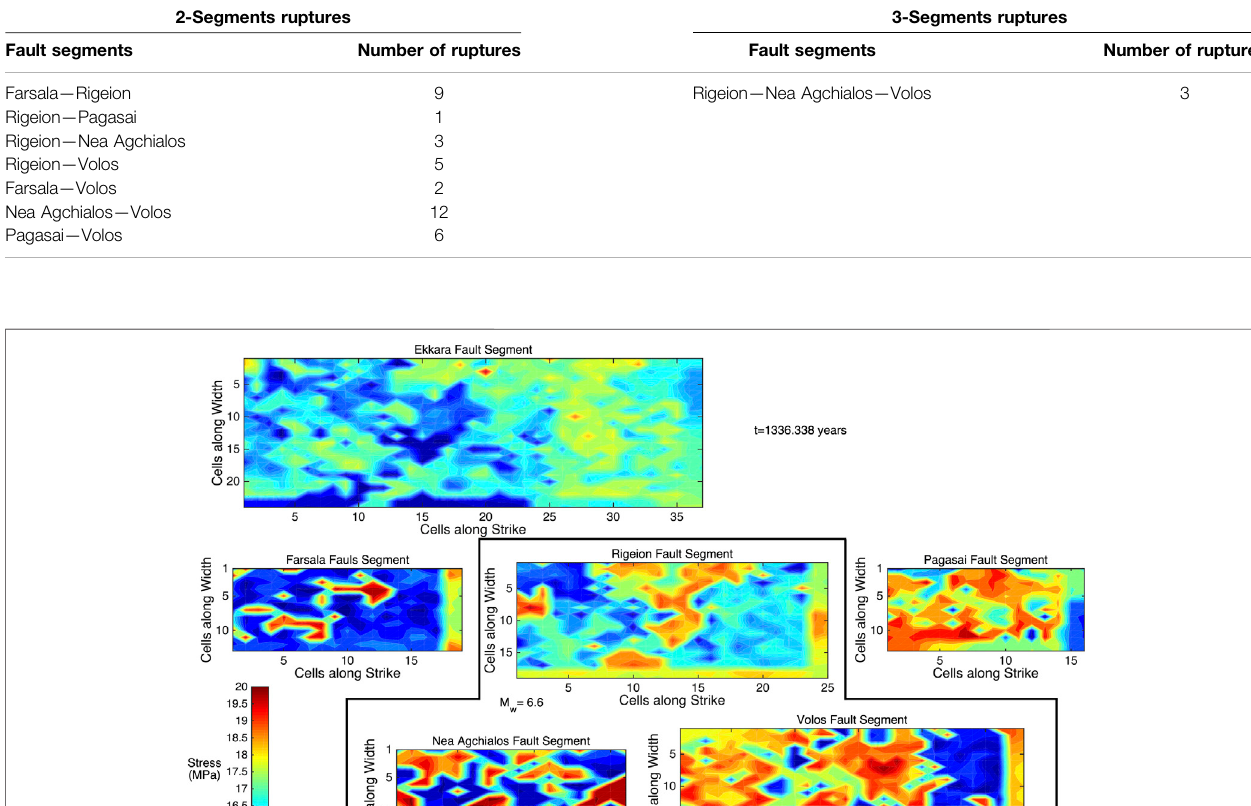
TABLE 5 | Number of 2 and 3 segments ’ multiple ruptures for all the combinations of the participating fault segments of the Southern Thessaly Fault Zone.